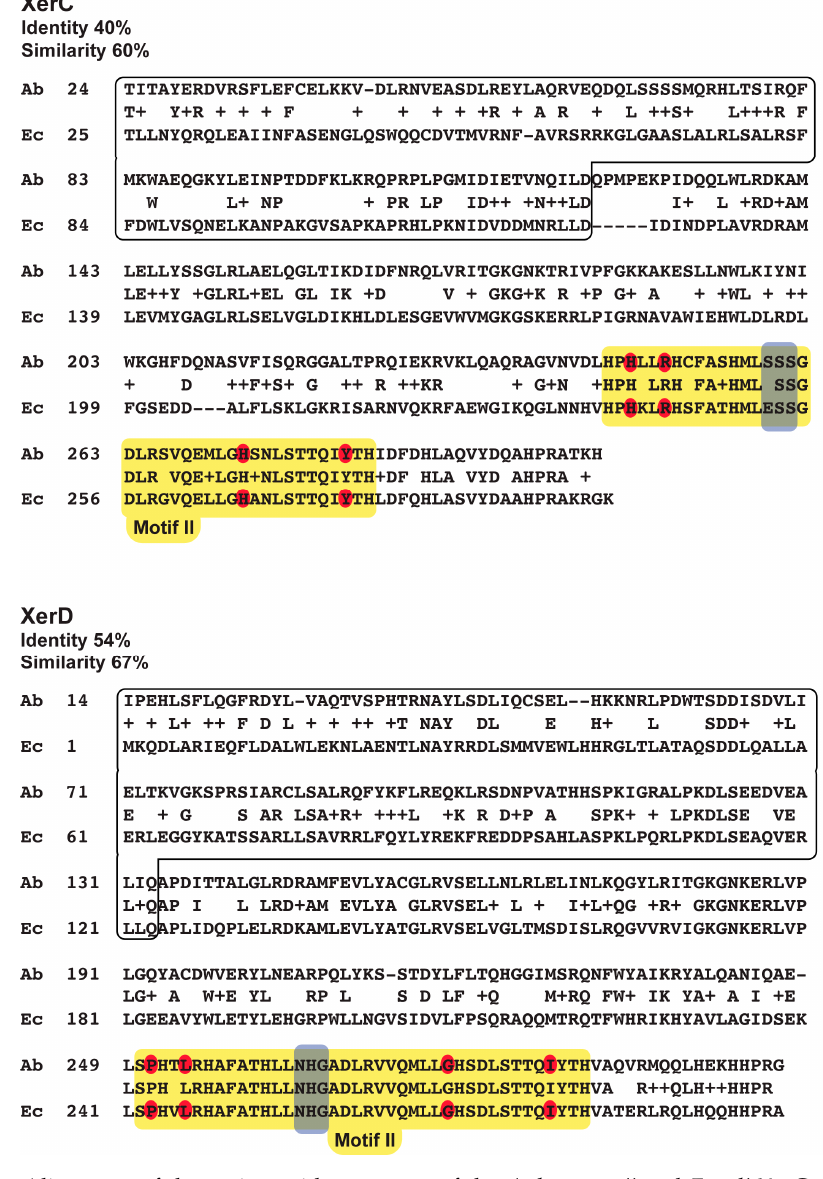
Figure 1. Alignment of the amino acid sequences of the A. baumannii and E. coli XerC and XerD. Catalytic, conserved amino acids are highlighted in red. The motif II is indicated by a solid yellow box. The tripeptides that act as acceptor in the donor–acceptor interaction with the C-terminal end of the partner protein are highlighted inside a solid gray box. The N-terminal region is boxed. Amino acid sequences are from accession numbers NP_418256.1 ( E. coli MG1655 XerC), NP_417370.1 ( E. coli MG1655 XerD), [43], VCCO00000000 ( A. baumannii A118 XerC and XerD)